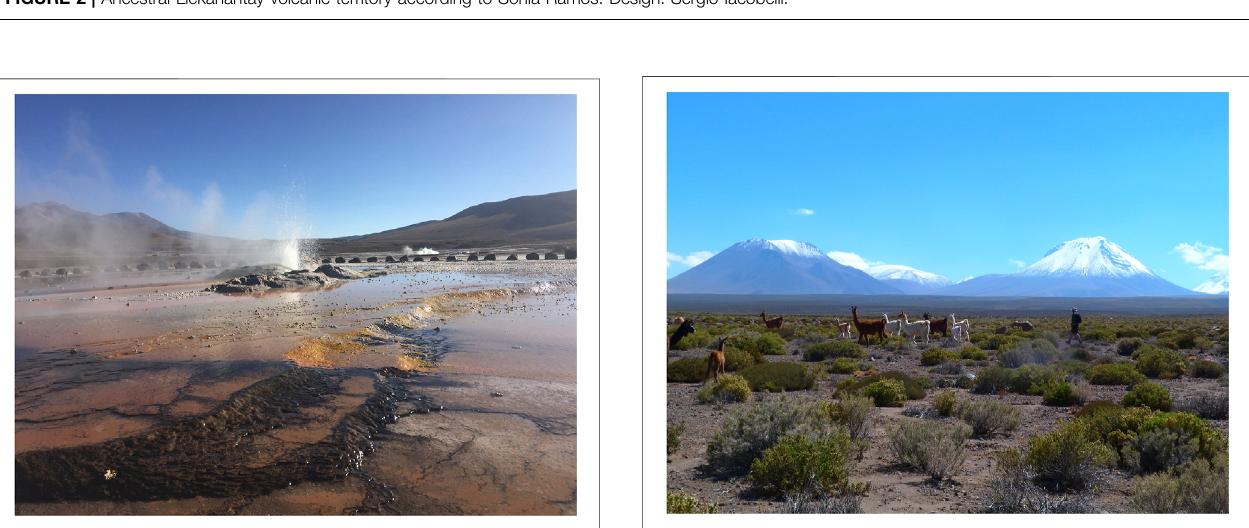
Frontiers in Earth Science |